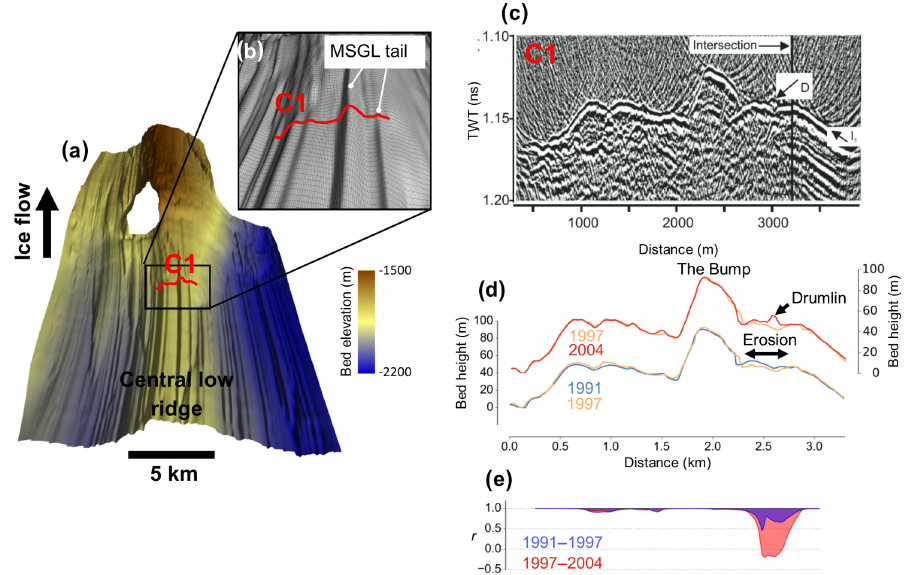
Figure 4. Geophysical data and bed picks from RIS (a) Radar derived bed DEM for RIS (King et al., 2016) showing geomorphology of the bed and the location of survey C1. (b) Close-up of the location of survey C1 showing the three-dimensional character of the bed. (c) Processed seismic section of survey C1. (d) Bed picks from repeat seismic surveys showing erosion and drumlin formation between 1991 and 2004 (Smith et al., 2007). (e) Correlation coefficient of repeat bed picks between 1991 and 2004 across a 500m moving